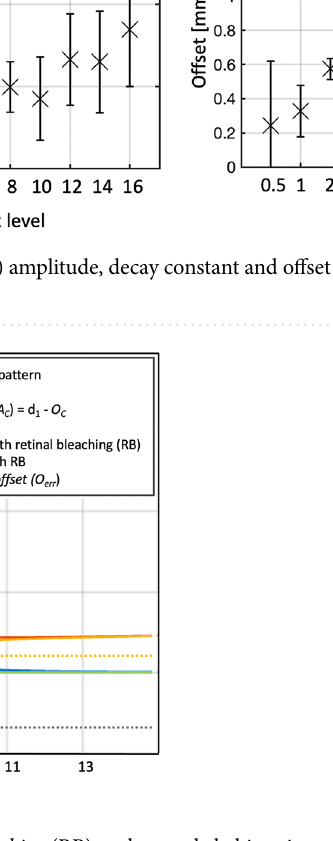
Figure 3. Depiction of the input of retinal bleaching (RB) to the startle habituation, using simulated data. In the classic decay model (blue) described by Beppi et al. 35 , the amplitude ( A C ) corresponds to the magnitude